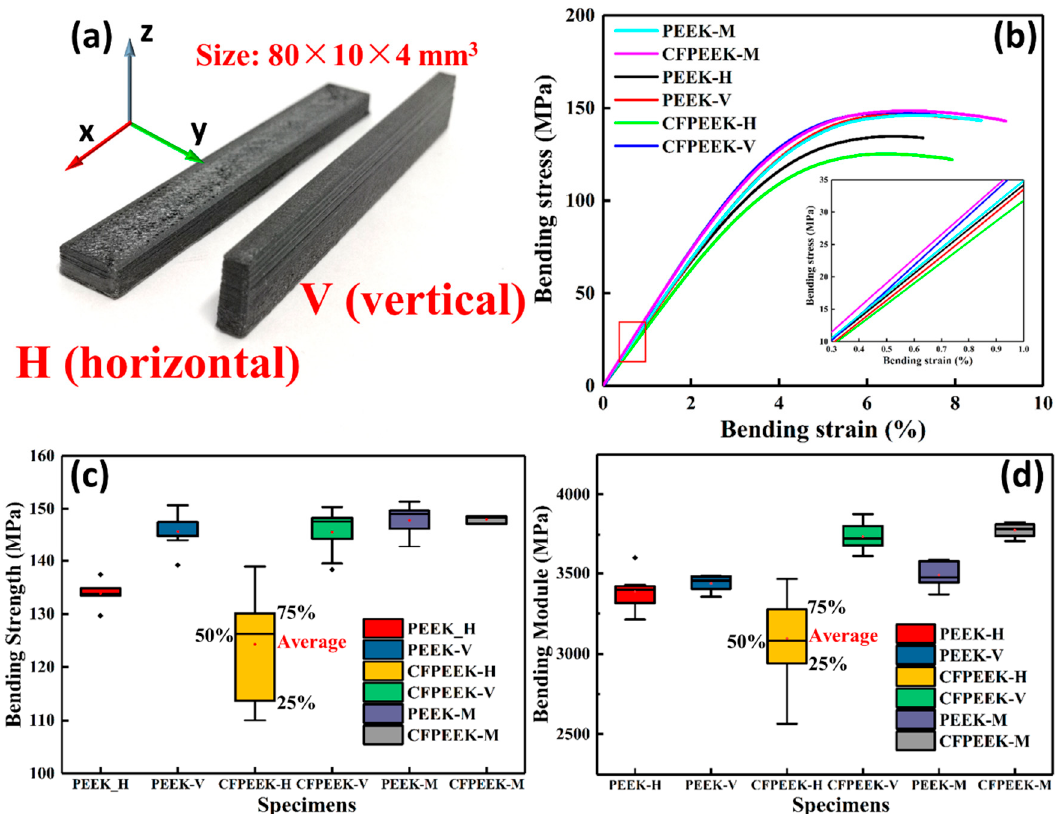
Figure 1. Flexural properties of printed and molding (M) polyether ether ketone (PEEK) and carbon fiber (CF) / PEEK specimens. ( a ) CF / PEEK bending specimens with orthogonal printing direction (horizontal and vertical) both printed according to ISO 178:2010 (size: 80 × 10 × 4 mm 3 ). ( b ) Typical stress to strain curves of flexural experiments. The inset in the bottom right corner shows the linear range that determines the module of each bending specimen. The boxplots of ( c ) bending strength and ( d ) bending modulus of flexural specimens, which indicate the distribution of experimental data.